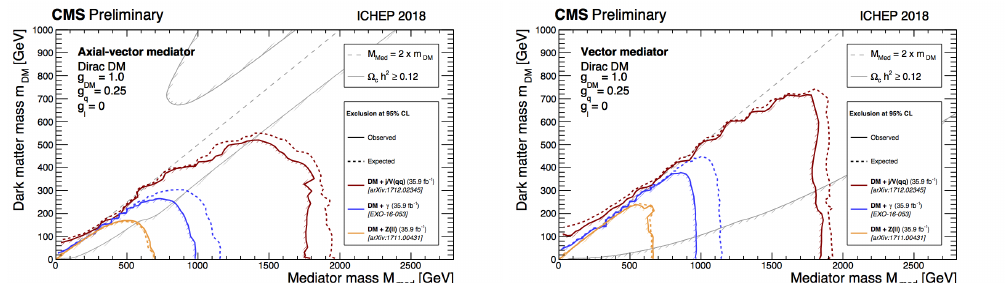
Figure 11. 95% CL observed and expected exclusion regions in m Med − m DM plane for different MET-based DM searches from CMS in the lepto-phobic Axial-vector model ( left ) and lepto-phobic Vector model ( right )